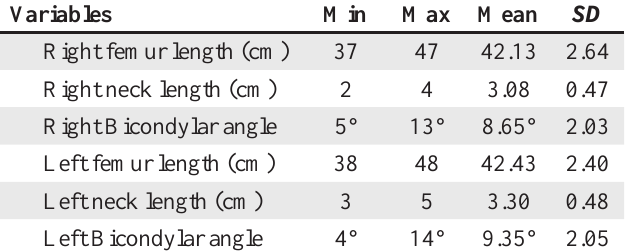
Table 1 : Morphometric parameters of dry